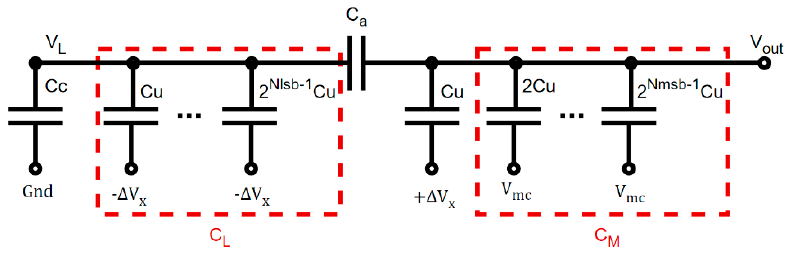
Figure 5. Illustration of the calibration algorithm.